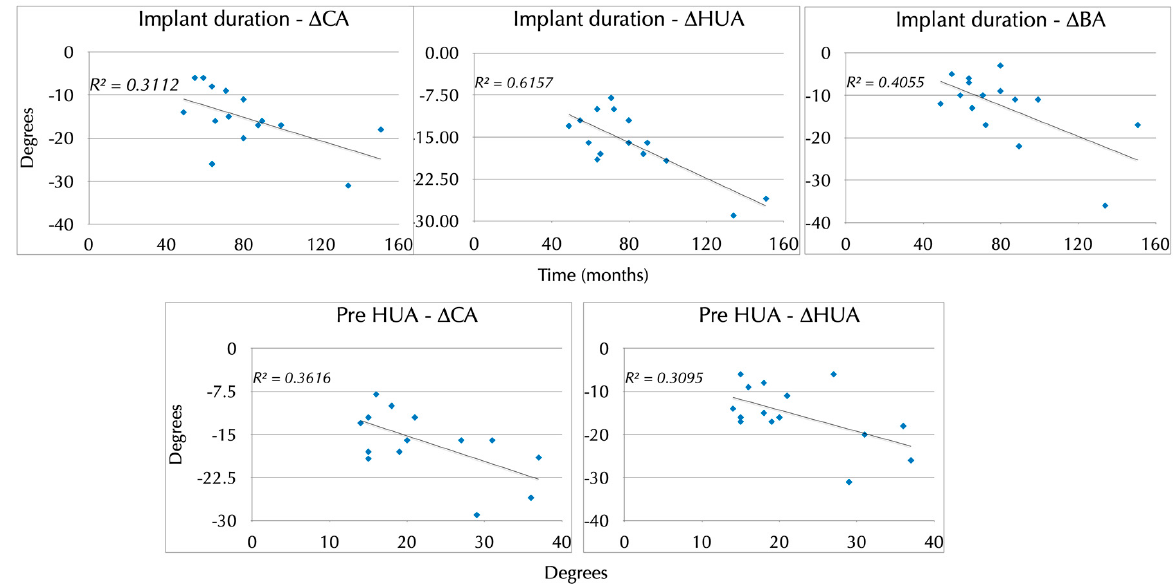
Figure 8. Scatterplot representing the correlation between implant duration and the degree of clinical correction using the CA, and the radiological correction measured by the HUA ( p = 0.027) and the BA ( upper graphs ). Scatterplot representing the correlation between preoperative HUA in relation to CA degree correction and to HUA degree correction ( lower graphs ). CA, carrying angle; HUA, humero-ulnar angle, BA, Baumann angle.